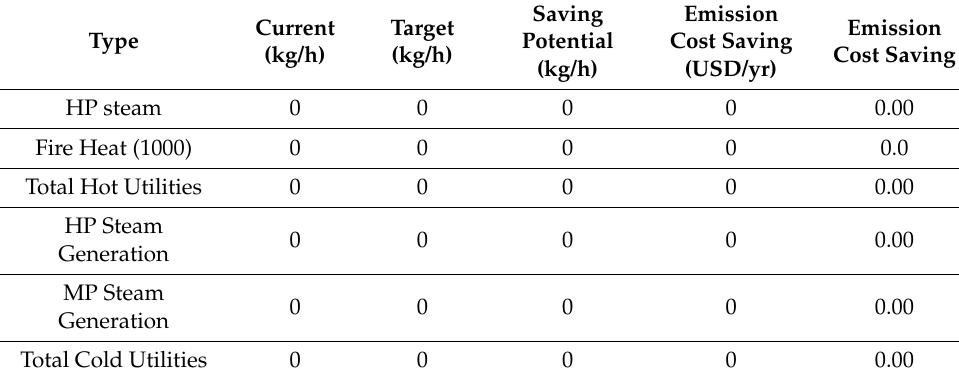
Table 7. Carbon Emission